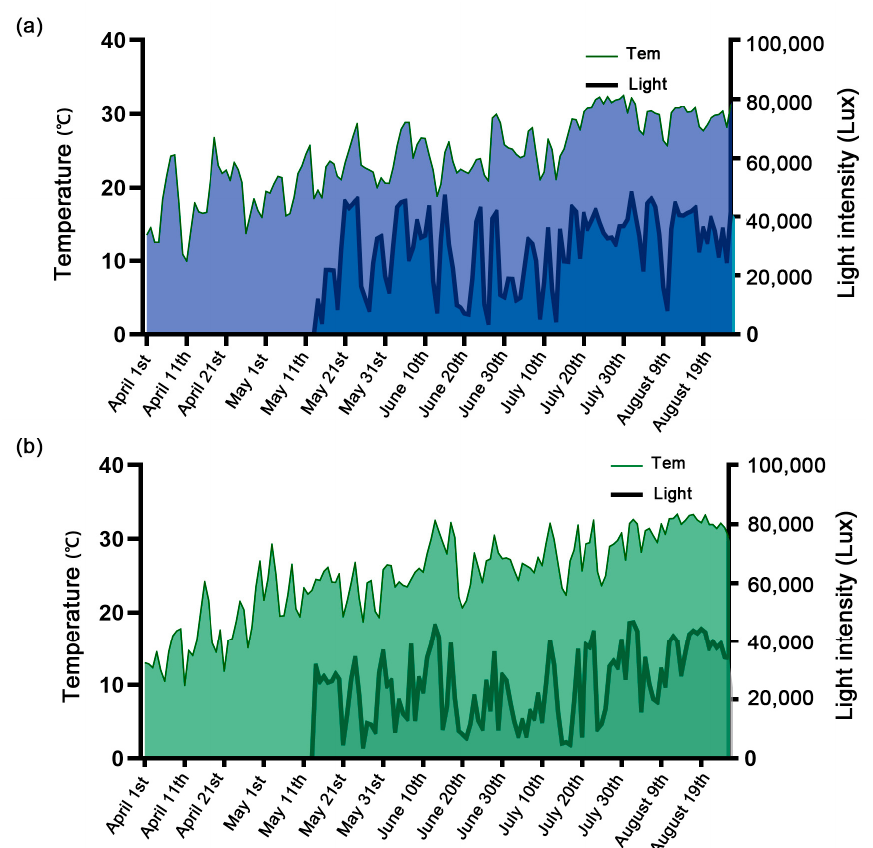
Figure 2. Diurnal variation of average light and temperature in 2019 and 2020. ( a ) Local average temperature and light in 2019. ( b ) Local average temperature and light in 2020.